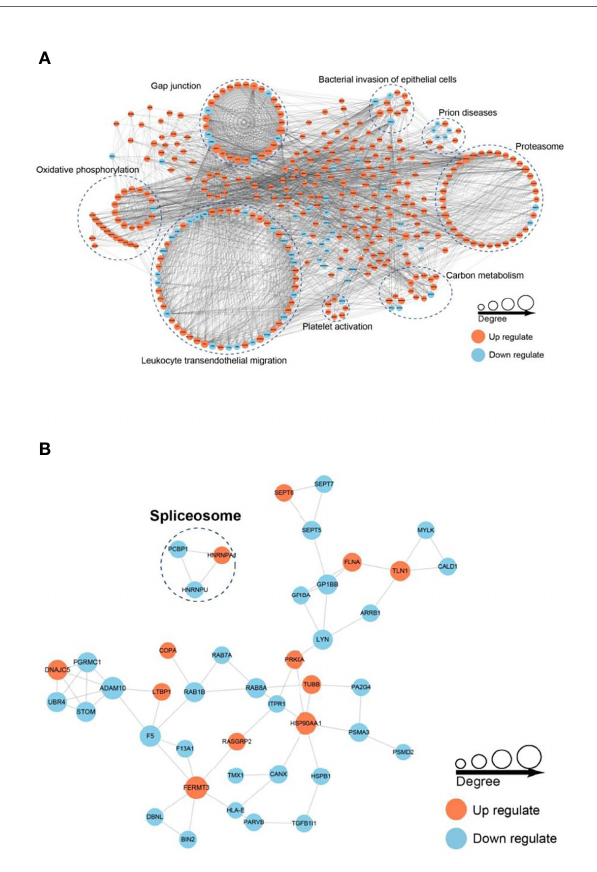
FIGURE 7 | Protein – protein interaction (PPI) network analysis of DEPs (A) and DPPs (B) . The STRING database was used to annotate the functional interactions of all the identi fi ed DEPs and